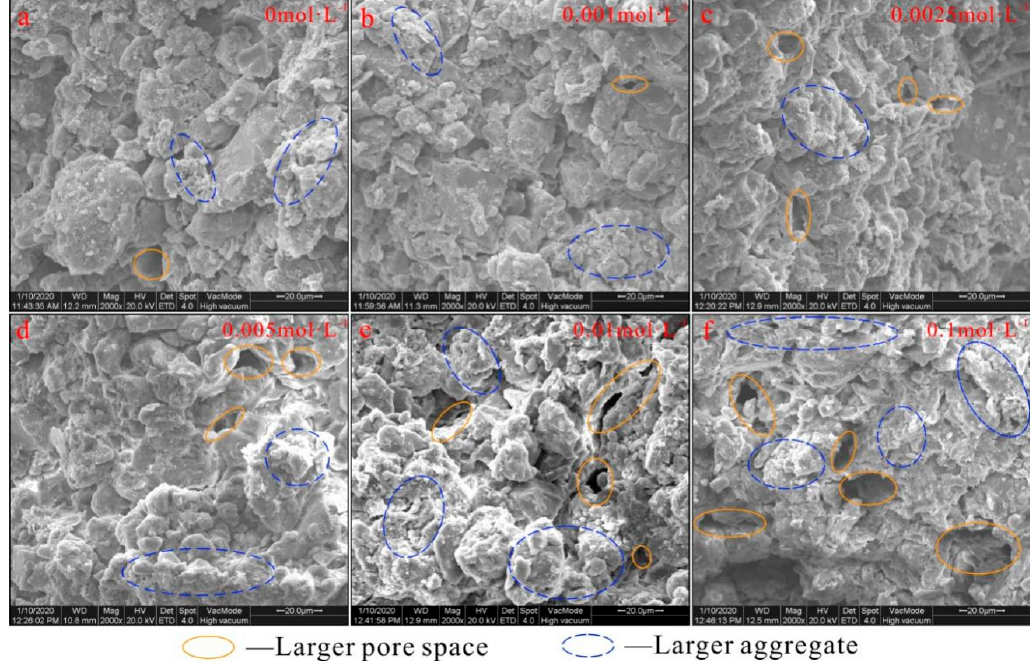
Figure 10. SEM images of the samples that were permeated by different NaCl concentrations. ( a ) 0 mol/L; ( b ) 0.001 mol/L; ( c ) 0.0025 mol/L; ( d ) 0.005 mol/L; ( e ) 0.01 mol/L; ( f ) 0.1 mol/L.